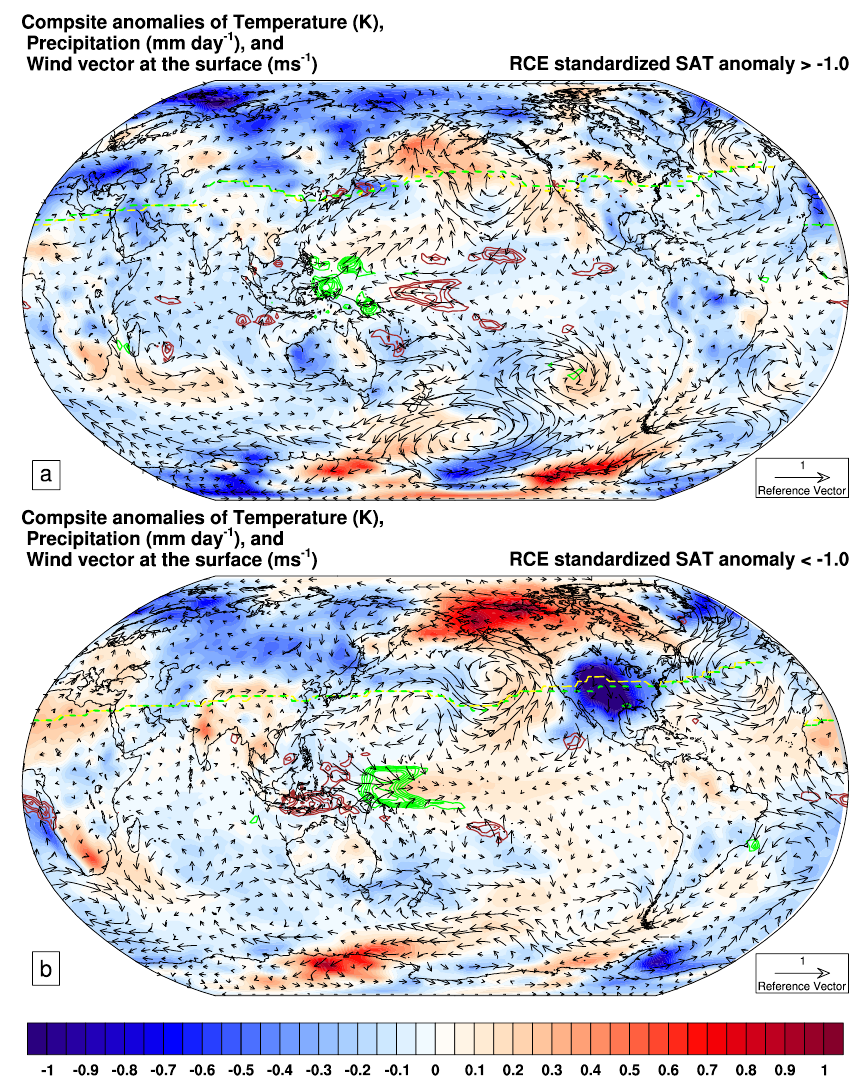
Figure 6. ( a ) Composite anomalies relative to the control simulation of surface air temperature (SAT in K, color scale), precipitation (mm/day, green contours are for positive and brown contours for negative anomalies, contours from − 2.0 to 2.0 with a spacing of 0.25) and wind vector (ms − 1 ) at the surface for conditions in which the standardized SAT in the RRM region is greater than − 1.0K; and ( b ) the same as ( a ) but for conditions in which the standardized SAT in the RRM region is smaller than − 1.0K. The green (experiment) and yellow (control) dotted lines represent the core of the jet stream (ms − 1 , max. zonal wind between 300 and